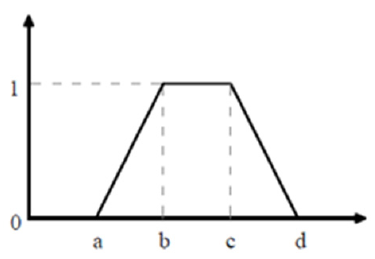
Figure 6. Trapezoidal membership function.